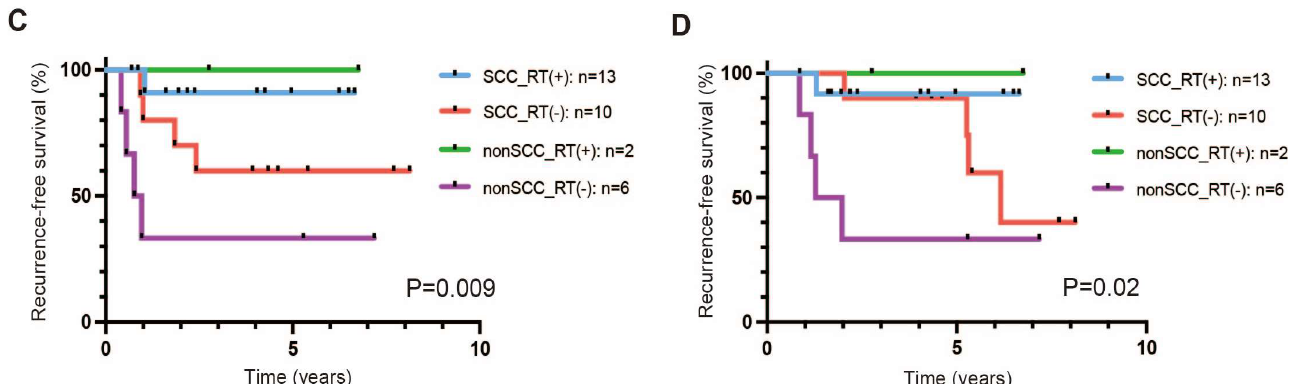
Figure 3. Prognosis of patients with (tumor and node) T2N1. ( A ) Recurrence free survival (RFS). ( B ) Overall survival (OS). ope+CT, patients who underwent surgery and chemotherapy (neoadjuvant or adjuvant); ope+RT, patients who underwent surgery followed by radiotherapy (including con- current chemoradiotherapy); and RT, patients who underwent radiotherapy (including concurrent chemoradiotherapy). ( C ) RFS by histological subtype. ( D ) OS by histological subtype. Patients were divided according to whether they had squamous cell carcinoma (SCC) or non–squamous cell carcinoma (non–SCC), and whether radiotherapy (including concurrent chemoradiotherapy) was performed or not. Survival curves were estimated by the Kaplan–Meier method and compared by the log–rank test.